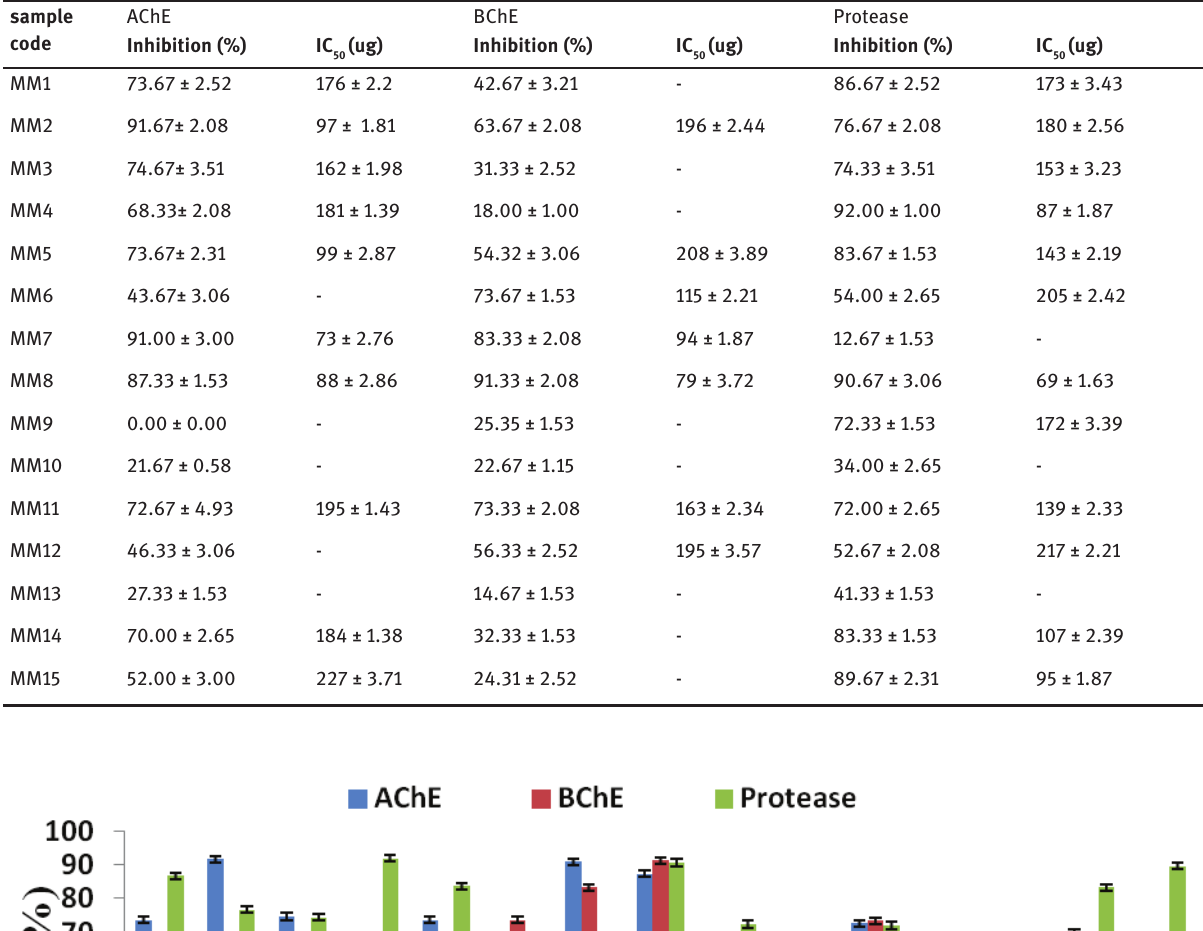
Table 4: Enzyme Inhibition Activity of Selected Plants.